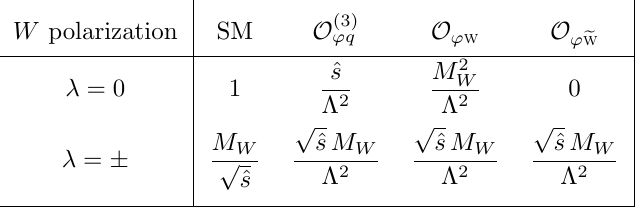
Table 2 . High energy behavior of the SM and BSM helicity amplitudes for pp ! Wh